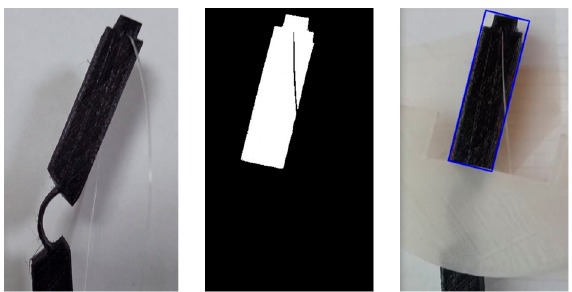
Figure 8. Object detection using image processing. ( left ) Original image of the 3D-printed finger. ( middle ) Segmented object region represented with white pixels in the segmented binary image. ( right ) Detected object bounded with an extracted minimal rectangle (blue-colored rectangle).